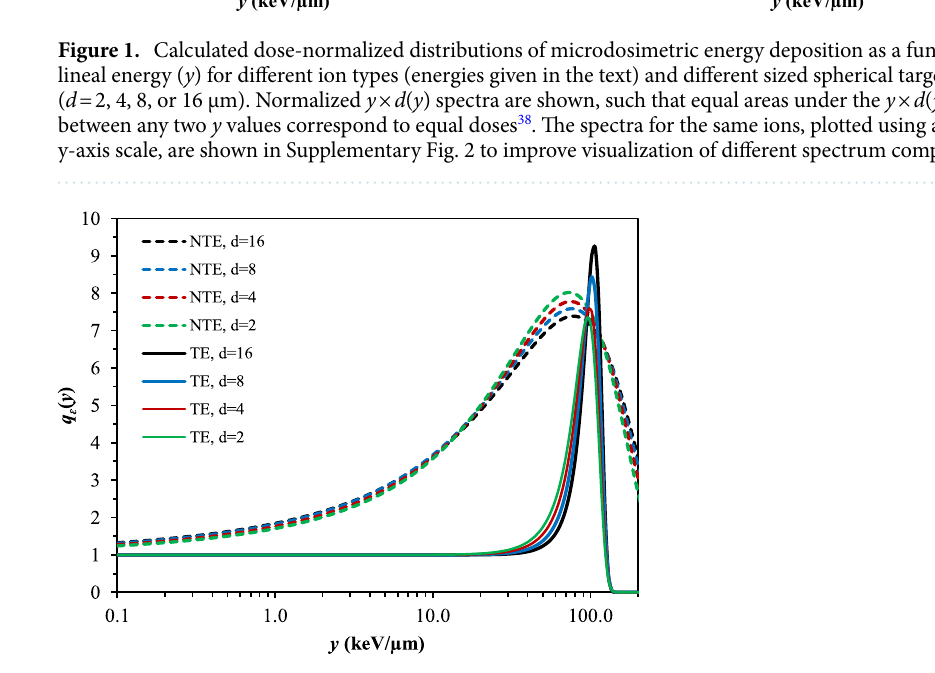
Figure 2. Best-fit radiation quality functions q ɛ ( y ) for targeted effects (TE, solid curves) and non-targeted effects (NTE, dashed curves), for different spherical target diameters (d in